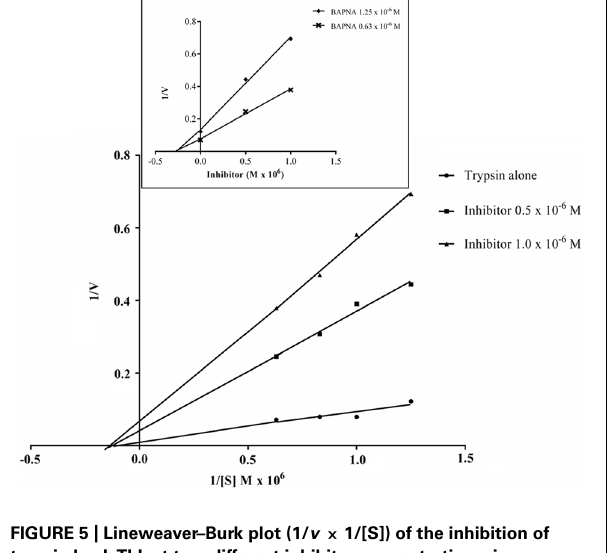
FIGURE 5 | Lineweaver–Burk plot (1/ v × 1/[S]) of the inhibition of trypsin by JcTI-I, at two different inhibitor concentrations, in conjunction with the Dixon plot (1/ v × [I], insert) for identification of K m , K i and the likely mechanism of enzyme inhibition. Each point represents the mean of three estimates.The standard deviation was less than